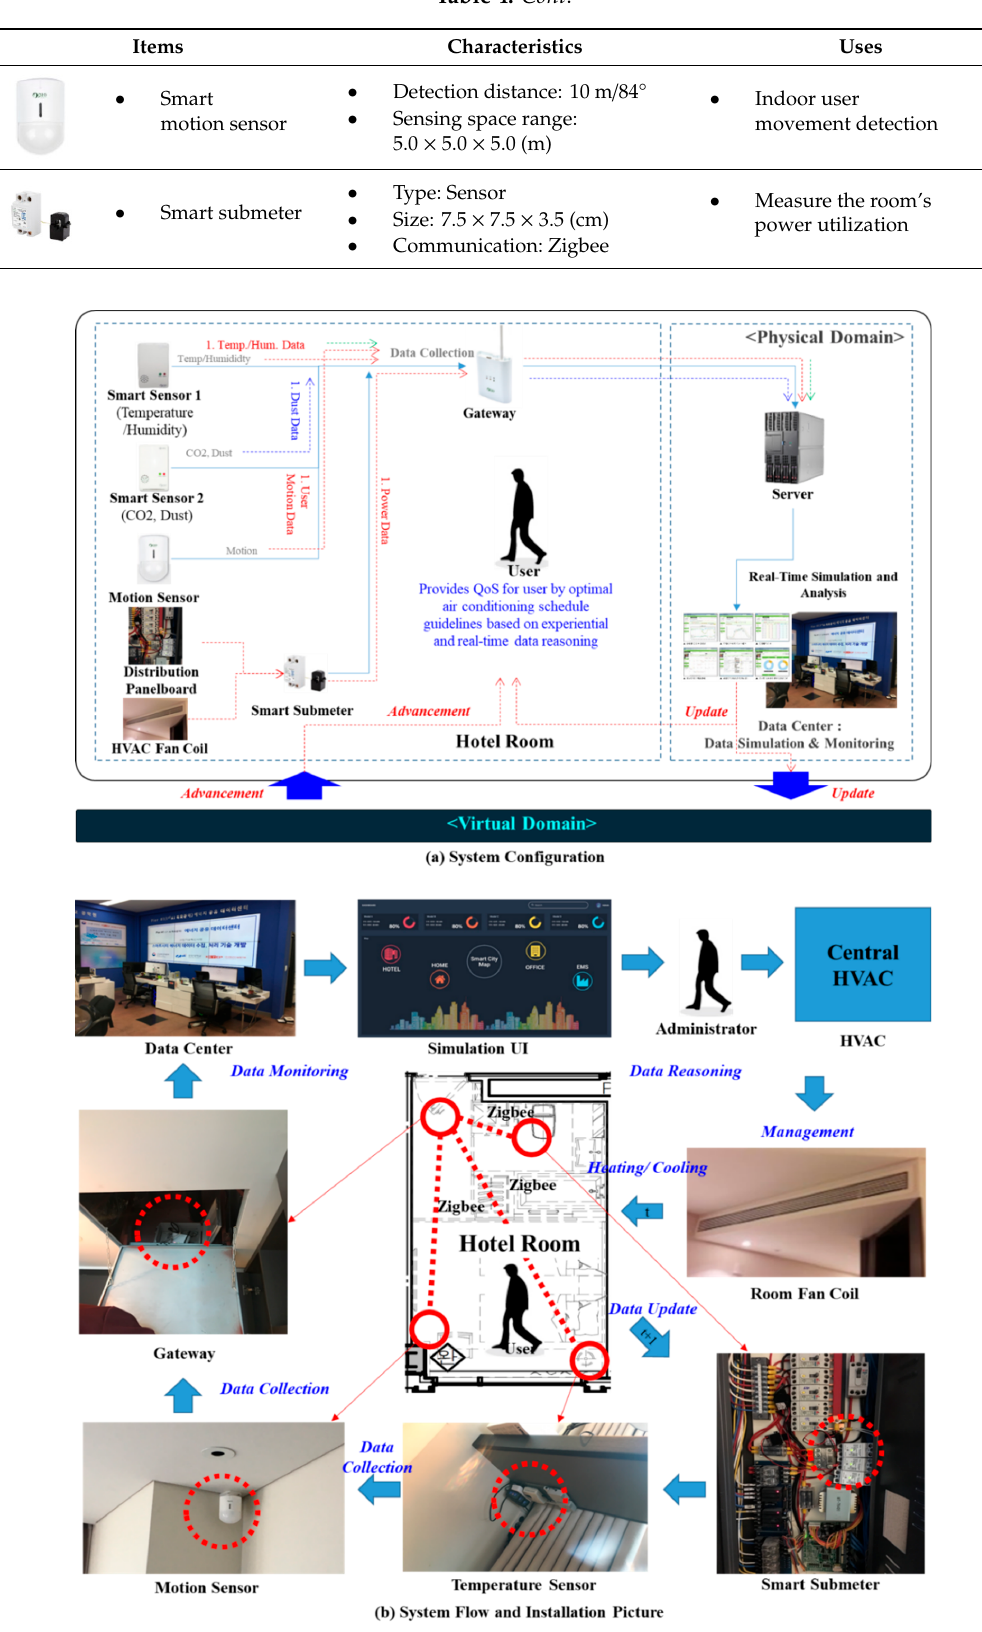
Figure 3. System Configuration.4.3. System Flow and Scenarios.